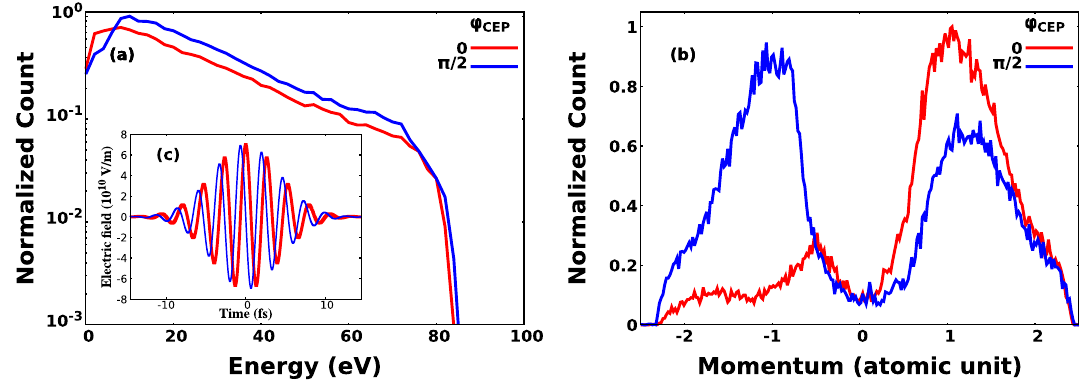
0 and π/ 2 . In the inset ( c ) the = 0 and π/ 2 is =